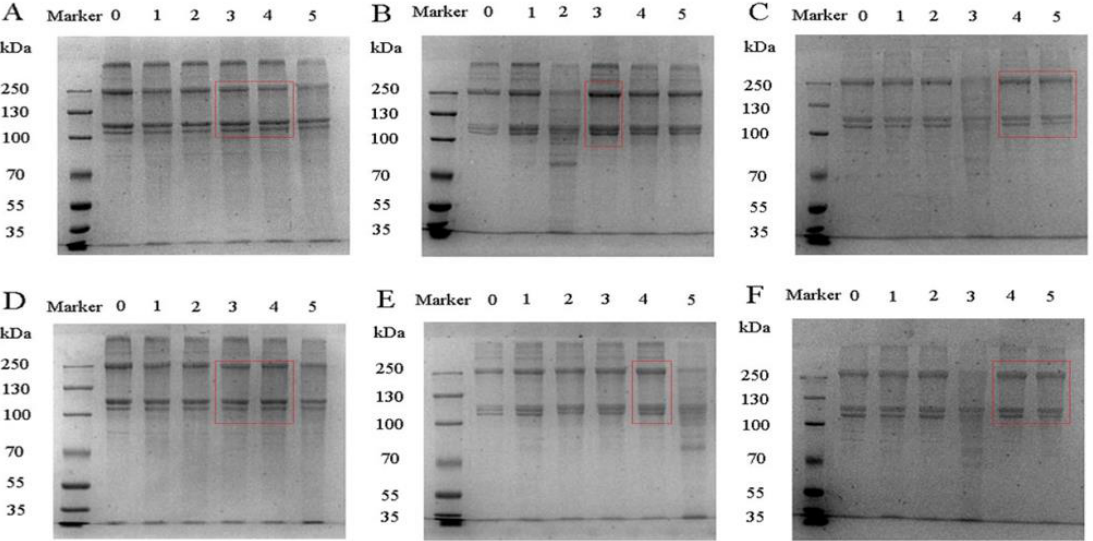
Figure 1. SDS map of fish gelatin. ( A ) (0–5): CS gelatin reduced, CS gelatin reduced at phosphorylation 0, 0.5, 1, 2 and 3 h, respectively; ( B ) (0–5): ES gelatin reduced, ES gelatin reduced at phosphorylation 0, 0.5, 1, 2 and 3 h, respectively; ( C ) (0–5): GS reduced, GS gelatin reduced at phosphorylation 0, 0.5, 1, 2 and 3 h, respectively; ( D ) (0–5): CS gelatin non-reduced, CS gelatin non-reduced at phosphorylation 0, 0.5, 1, 2 and 3 h, respectively; ( E ) (0–5): ES gelatin non-reduced, ES gelatin non-reduced at phosphorylation 0, 3, 2, 1 and 0.5 h, respectively and ( F ) (0–5): GS gelatin non-reduced, GS gelatin non-reduced at phosphorylation 0, 0.5, 1, 2 and 3 h, respectively.